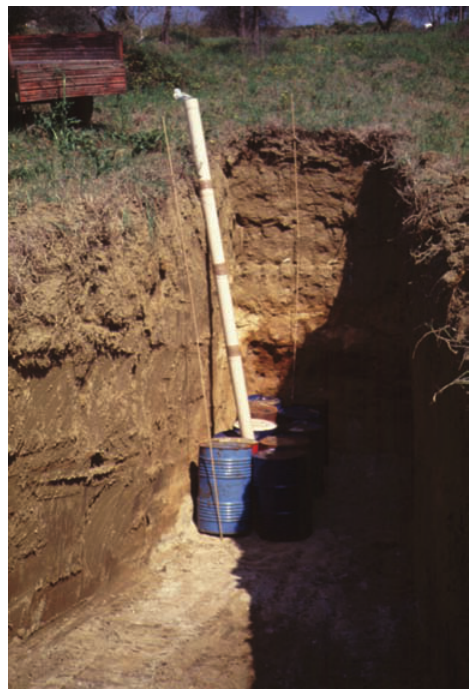
Figure 1. Photograph of the preparation of the steel-drum